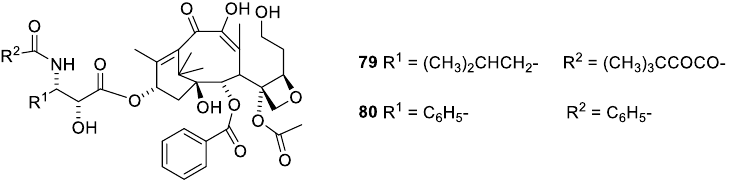
Figure 21. Seco analogues of paclitaxel [70].